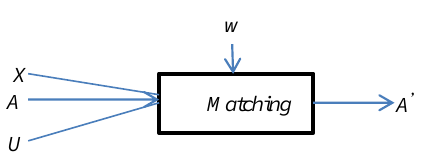
Figure 5. The matching